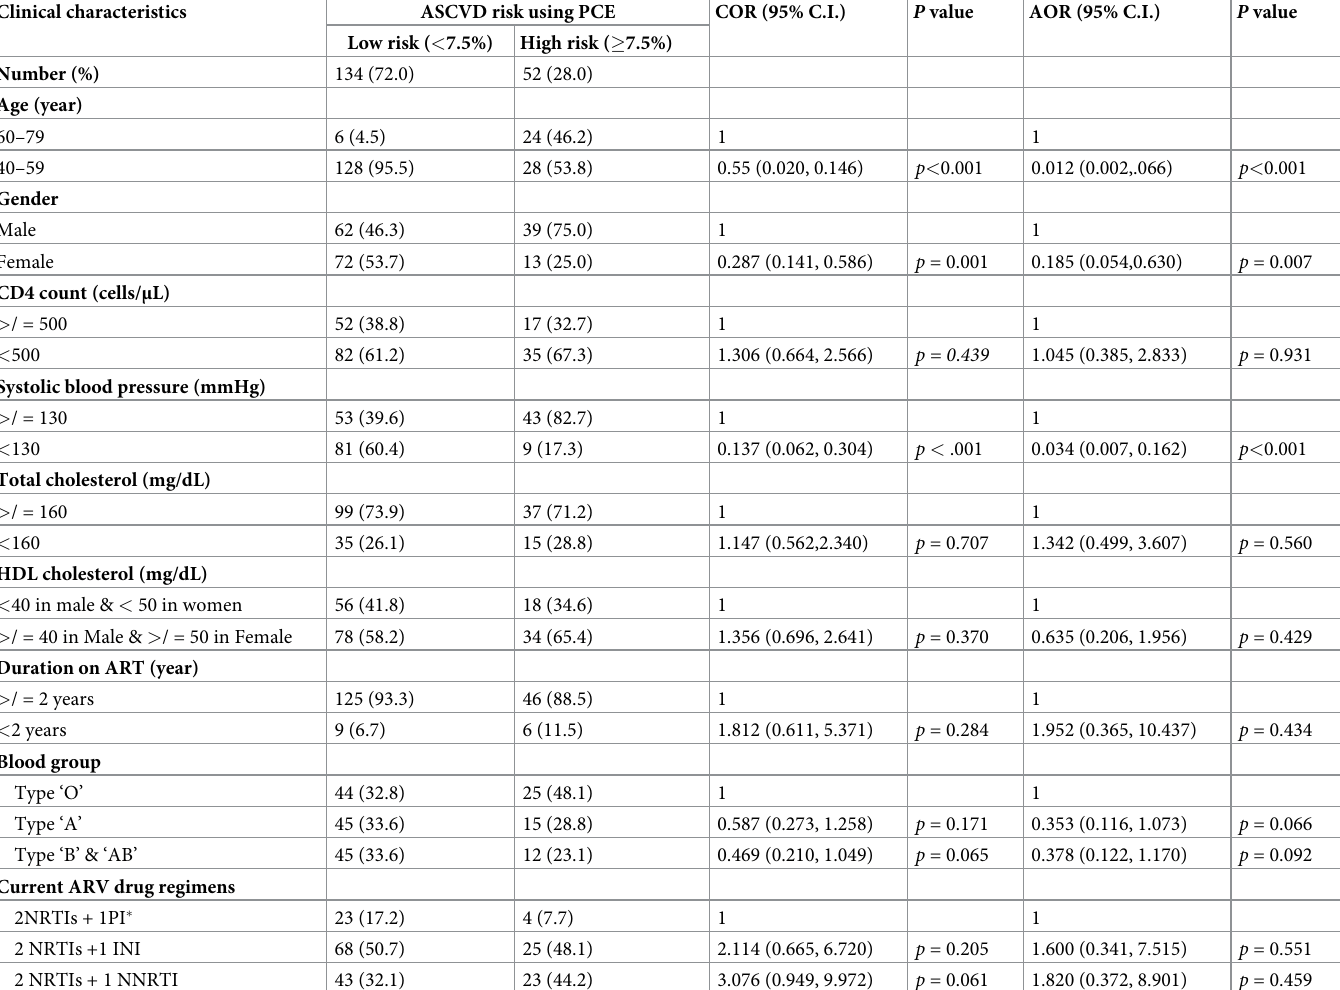
Table 5. Association between ASCVD risk using PCE and clinical characteristics among people living with HIV/AIDS age 40 to 75 years at Zewditu Memorial Hos- pital, Addis Ababa, Ethiopia. Clinical